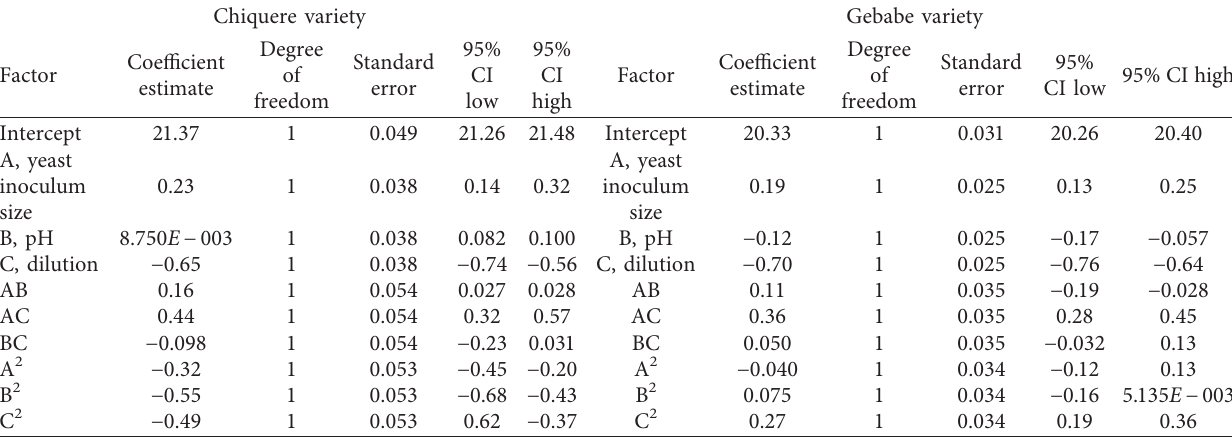
Table 6: Regression coefficients and the corresponding 95% CI high and low Chiquere and Gebabe variety ethanol yield of sweet sorghum.